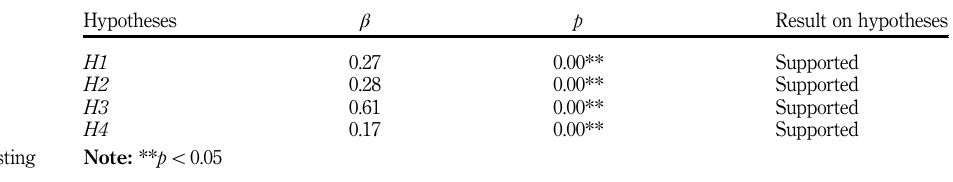
Table IV. Goodness-of-fit indices of structural model